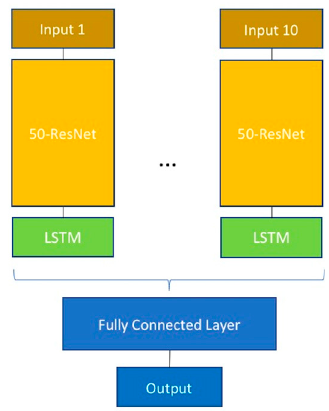
Figure 3. Overview of Contect’s Deep Neural Network